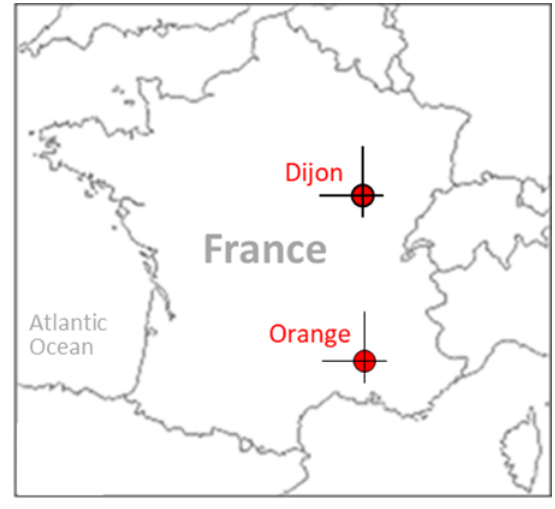
Figure 2. Case study (Orange and Dijon Stations): location map.